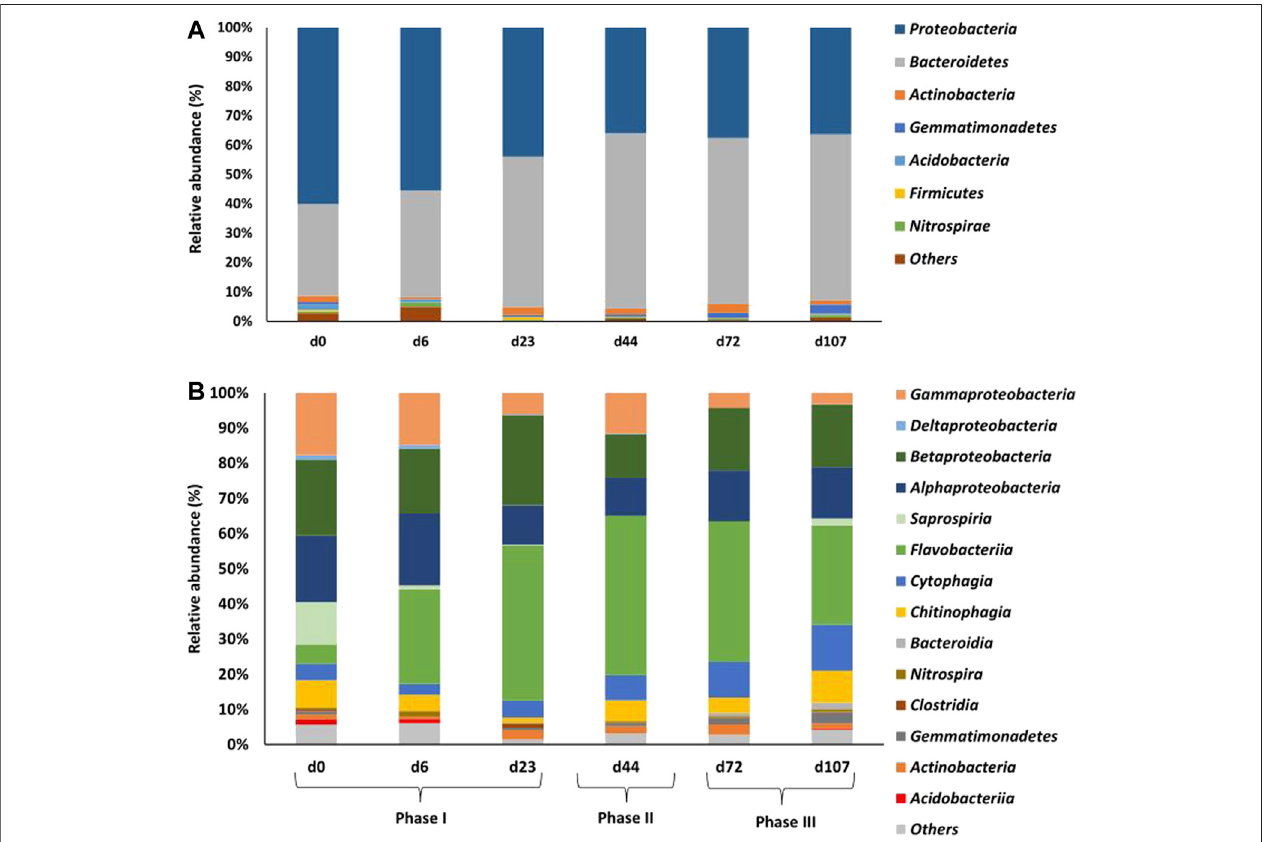
FIGURE 4 | Relative abundance of bacterial phyla (A) and classes (B) in AGS biomass throughout the different operational days and corresponding phases.